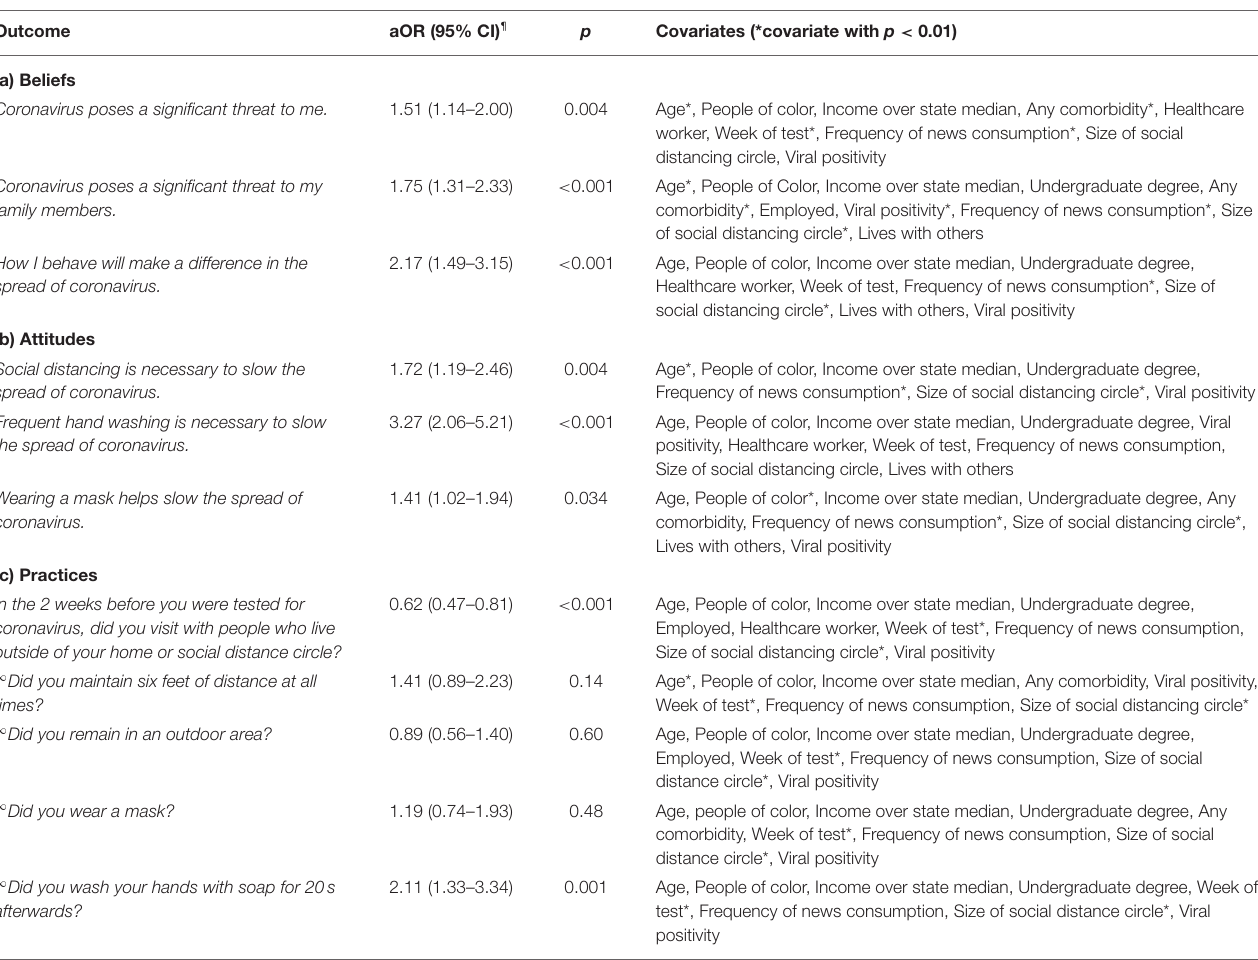
TABLE 3 | Adjusted odds ratios, 95% confidence intervals, and covariates for multivariable logistic regression models assessing the relationship between gender identity and SARS-CoV-2 (a) beliefs, (b) attitudes, and (c) practices. Outcome aOR (95% CI) ¶ p Covariates (*covariate with p < 0.01)